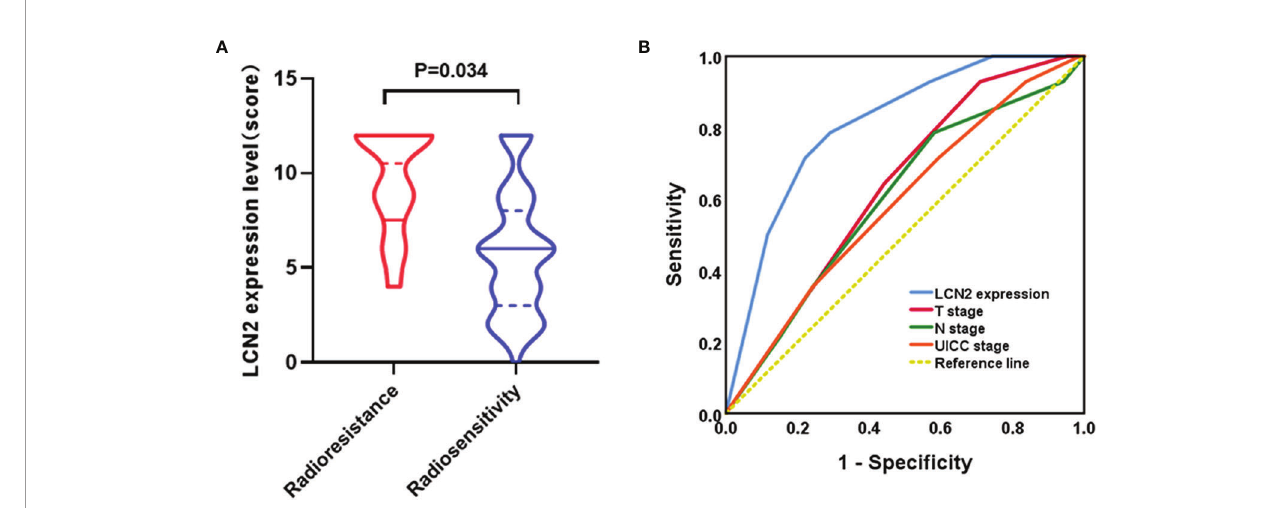
FIGURE 4 | LCN2 is a potential biomarker for predicting nasopharyngeal carcinoma (NPC) radioresistance. (A) LCN2 expression was signi fi cantly higher in radioresistant NPC tissues than in radiosensitive NPC tissues ( P = 0.034). (B) Receiver operating characteristic (ROC) curves for the predictive value of using LCN2 expression, T stage, N stage, and UICC stage to discriminate between radioresistant NPC and radiosensitive NPC. The LCN2 level displayed the largest area under the curve (AUC) among the four